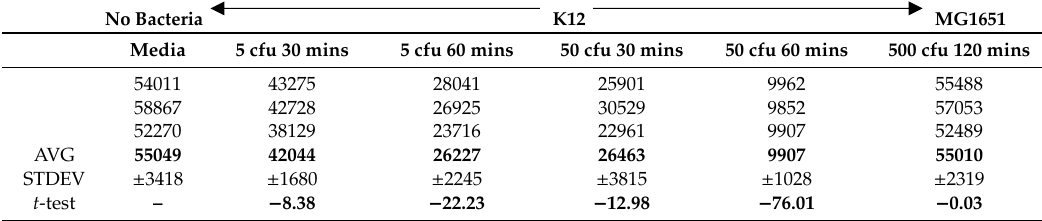
Table A2. Raw numbers and statistical analysis of the data shown in Figure 2. Area under the response curve from the Attenu assay is shown in the first 3 rows. The type of bacteria is listed above the Table. Averages and statistical analysis are shown in the last 3 rows.